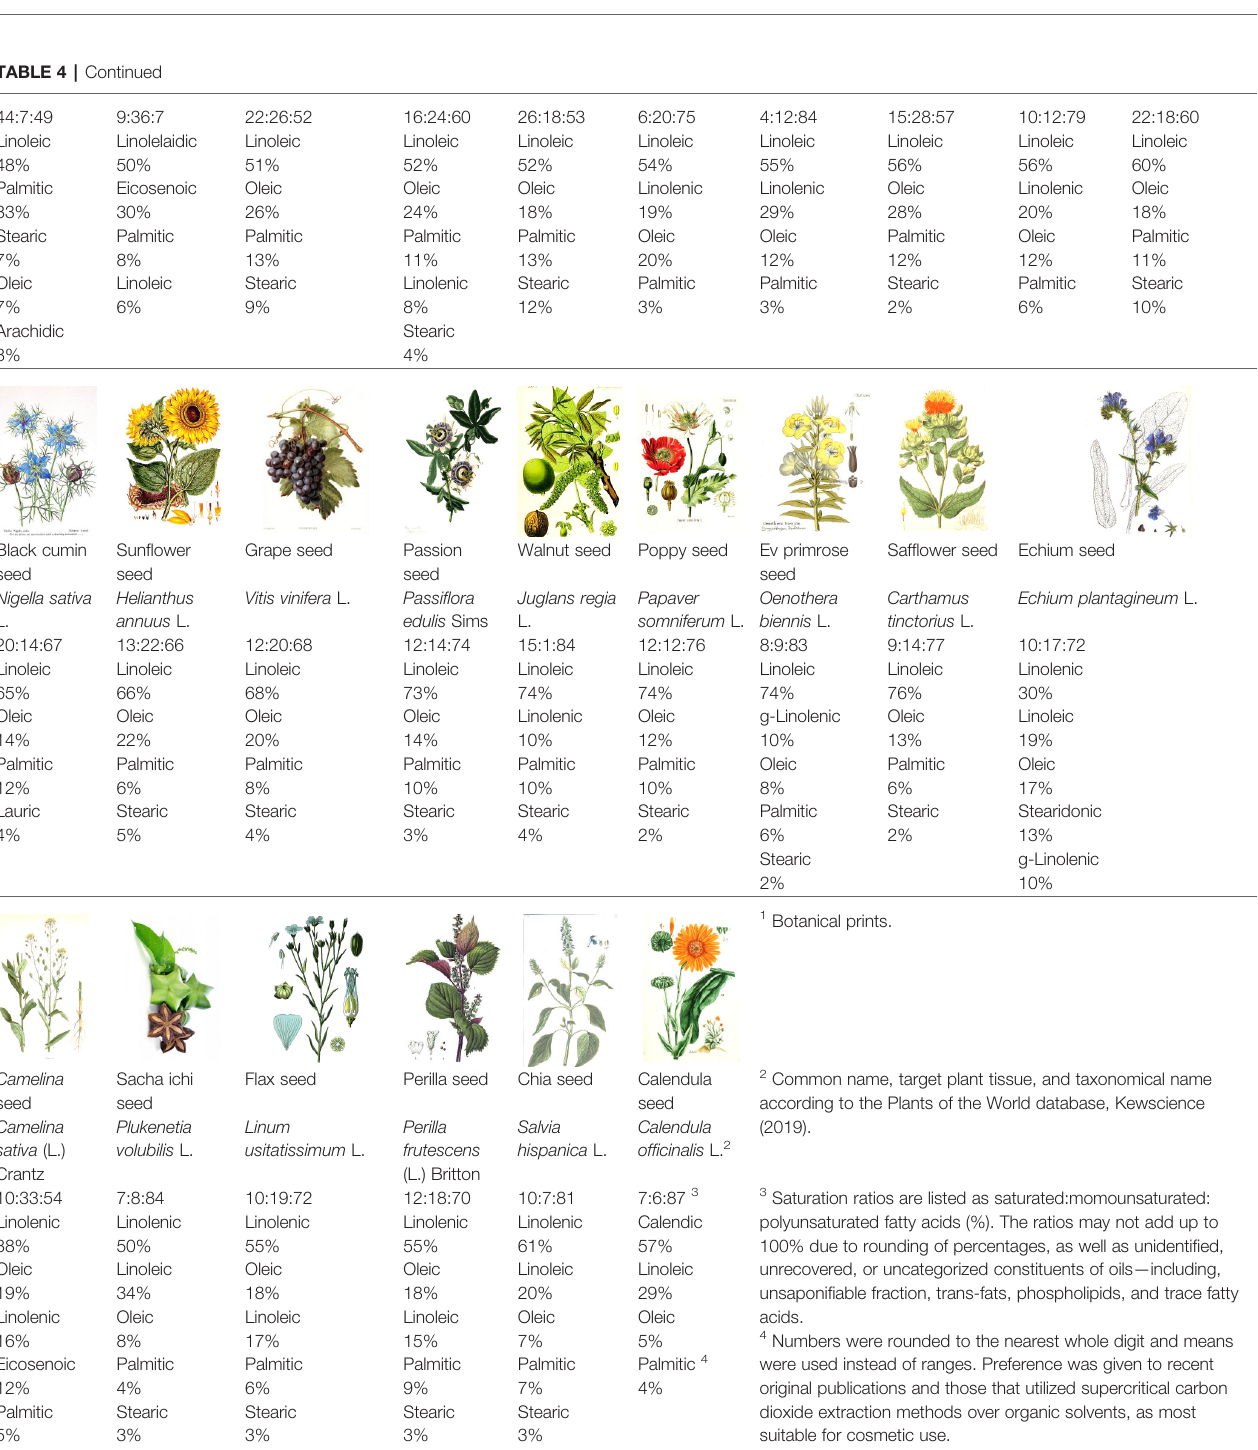
3 Saturation ratios are listed as saturated:momounsaturated: polyunsaturated fatty acids (%). The ratios may not add up to 100% due to rounding of percentages, as well as unidenti fi ed, unrecovered, or uncategorized constituents of oils — including, unsaponi fi able fraction, trans-fats, phospholipids, and trace fatty